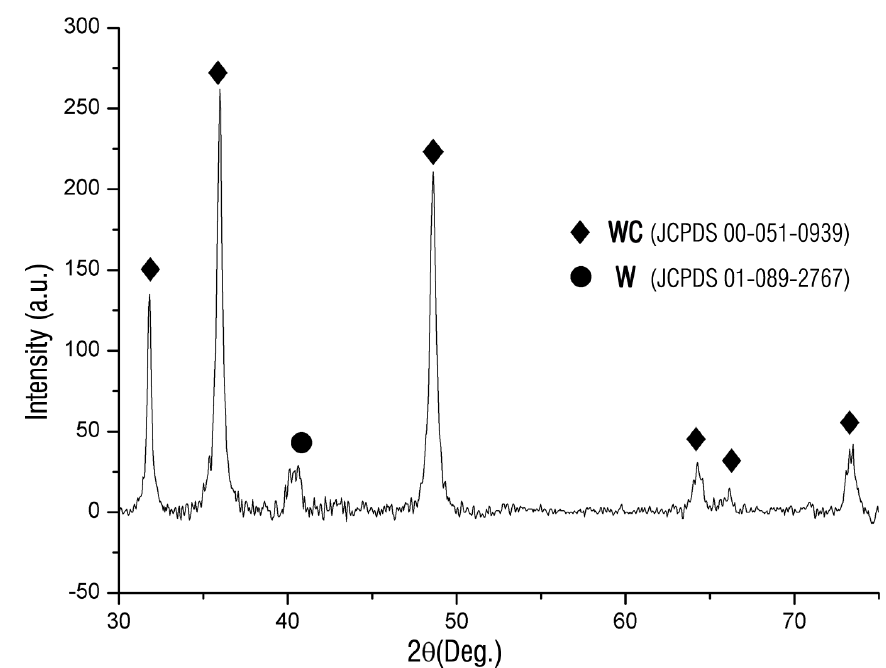
Figure 5. XRD pattern of the HVOF 86WC-10Co-4Cr